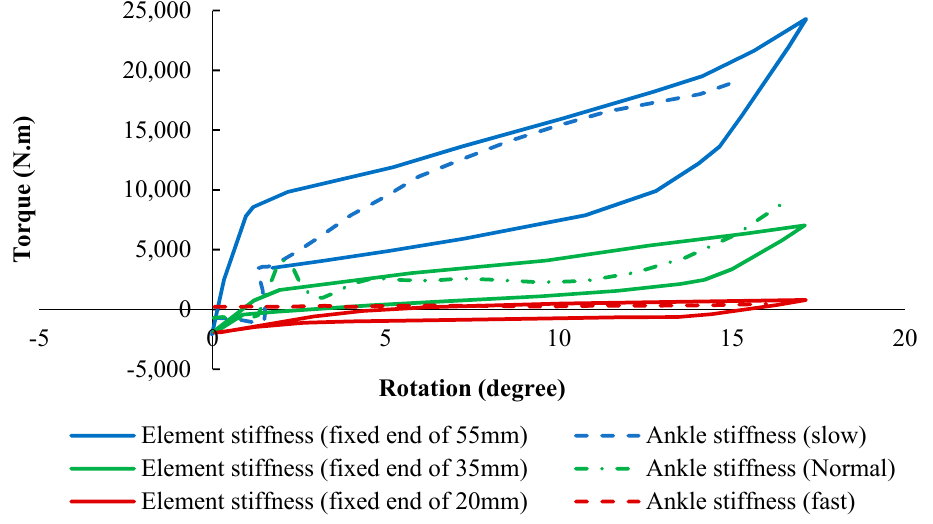
Figure 25. The stiffness results for SMA hinge fixed in different positions (simulation) in comparison with that of the healthy ankle in normal, slow and fast walking [53].